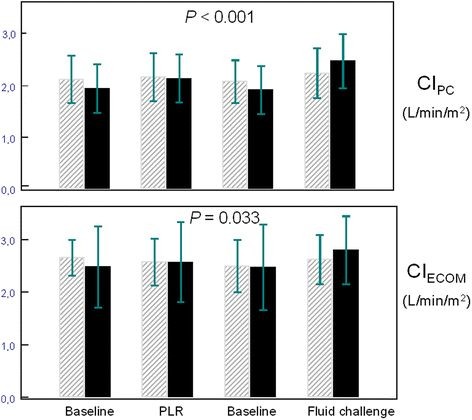
CIPCand CIECOMat baseline, during passive leg raising and after fluid challenge in responders (black boxes) and non responders (striated grey boxes). Values are mean ± SD. P value refers to ANOVA (two-factor study with repeated measures on one factor). CIECOM = cardiac index determination using ECOM (L.min-1.m-2); CIPC = cardiac index determination using pulse contour analysis (L.min-1.m-2); PLR = passive leg raising.